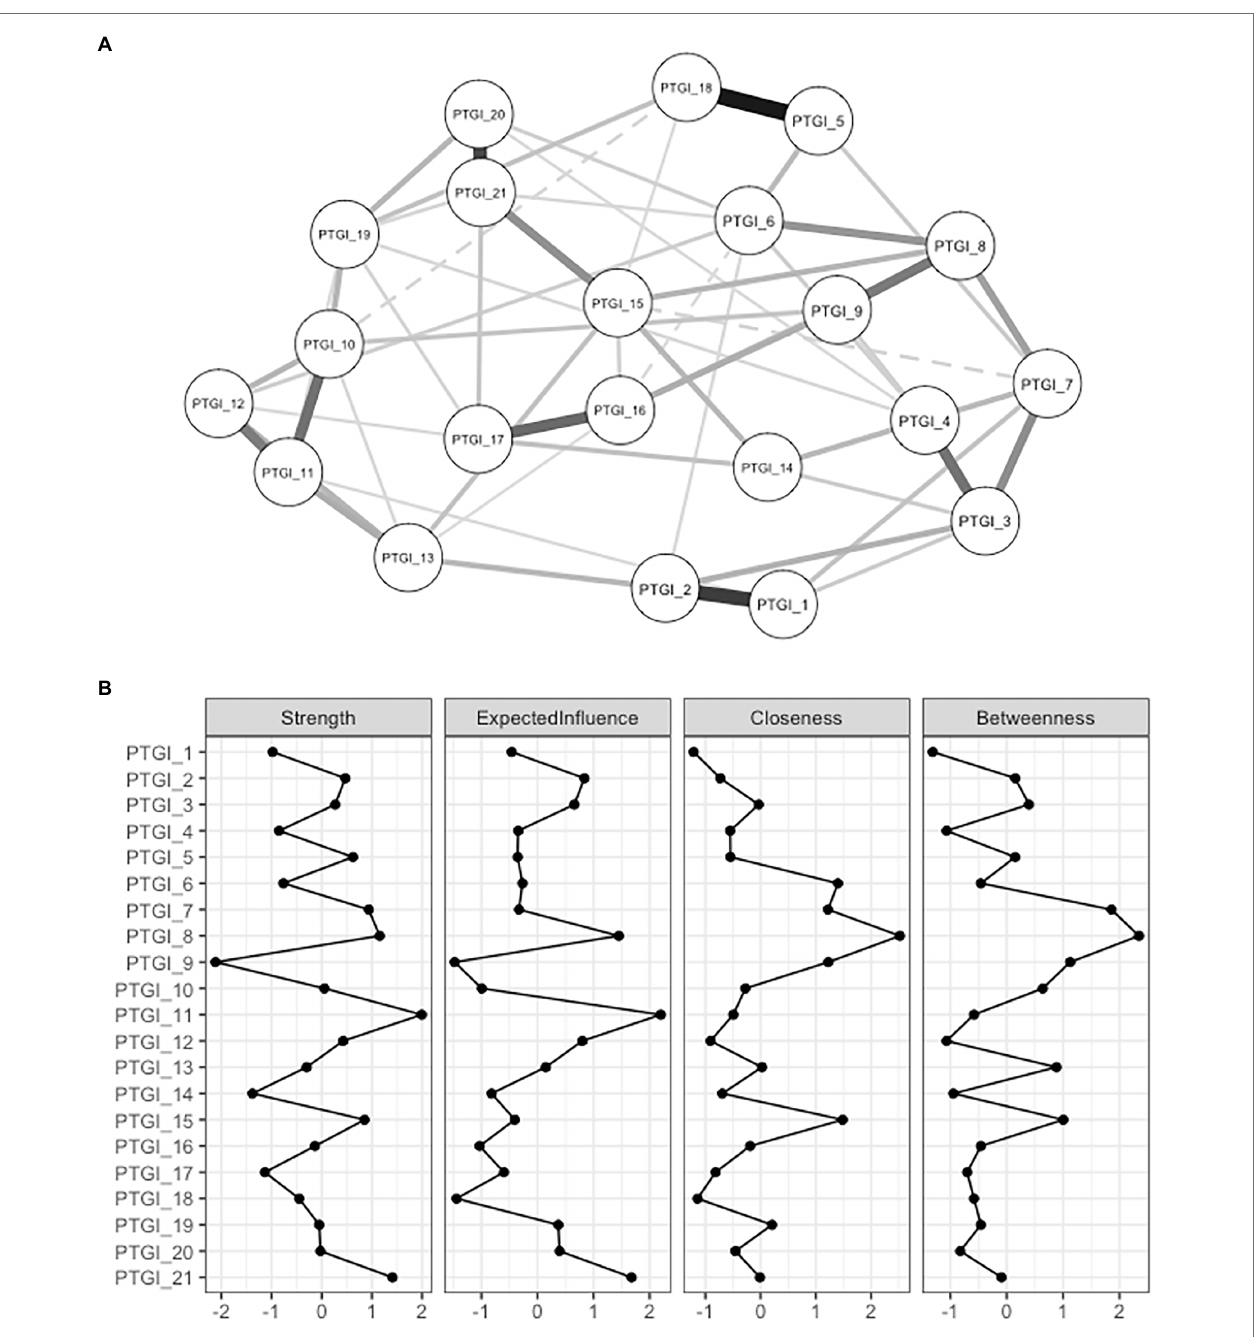
FIGURE 1 | Visualization of a network of the PTGI’s items and their centrality